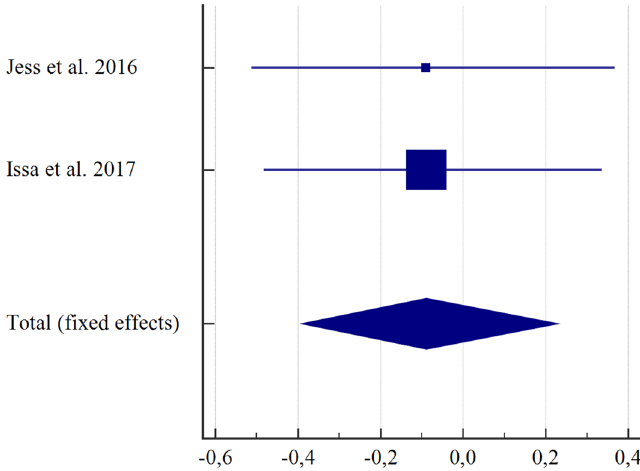
Figure 3. Subgroup correlation analysis between ANI and NRS in individuals submitted to electrical stimulus (r = − 0.089; CI = − 0.390 to 0.228, I 2 = 0%). The fixed-effect model was used. MedCalc Statistical Software version 19.2.6 (MedCalc Software bv, Ostend, Belgium; https:// www. medca lc. org;